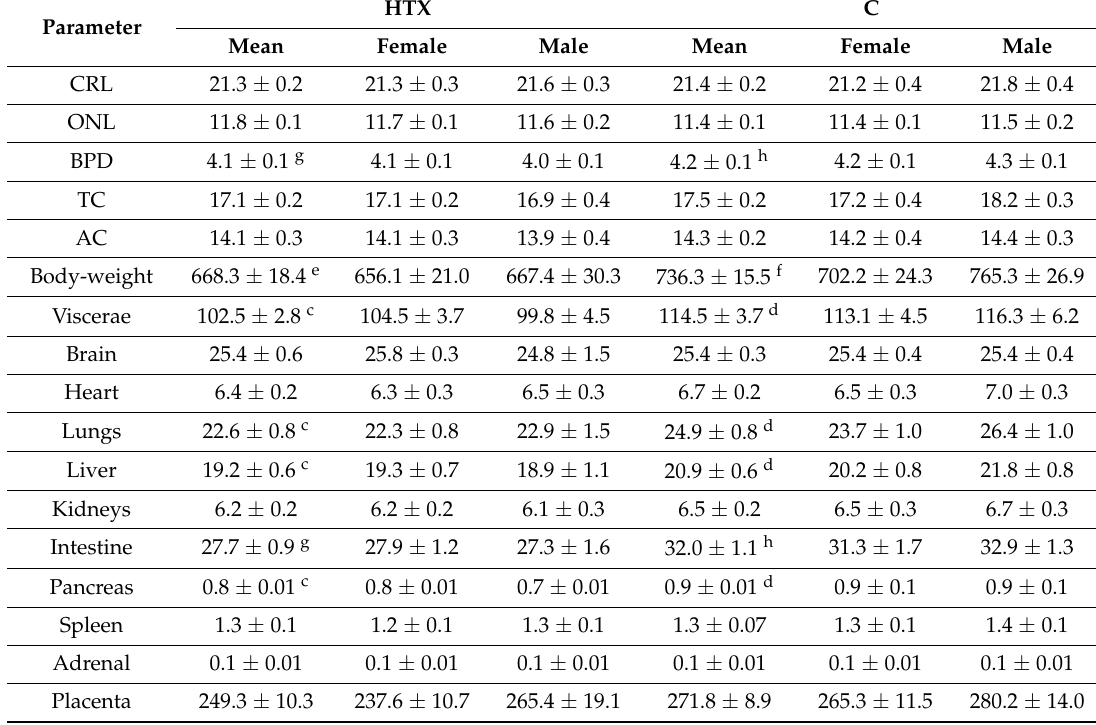
Table 3. Fetal development at day of sampling (Day 100 of pregnancy). Mean values ( ± SEM) and differences for sexes in treated (Hydroxytyrosol; Group HTX) and control fetuses (Group C). CRL accounts for Crown-rump Length, ONL for Occipito-Nasal Length, BPD for Biparietal Diameter, TC for Thoracic Circumference and AC for Abdominal Circumference. Superscript letters indicate significant differences between groups: a (cid:54) = b: p < 0.9, c (cid:54) = d: p < 0.05, e (cid:54) = f: p < 0.01, g (cid:54) = h: p < 0.005. Parameter